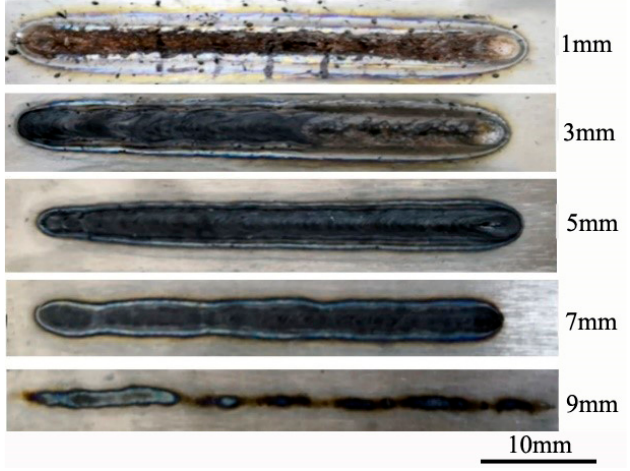
Figure 2. Macroscopic morphology of wet laser welding seam under different water depths.